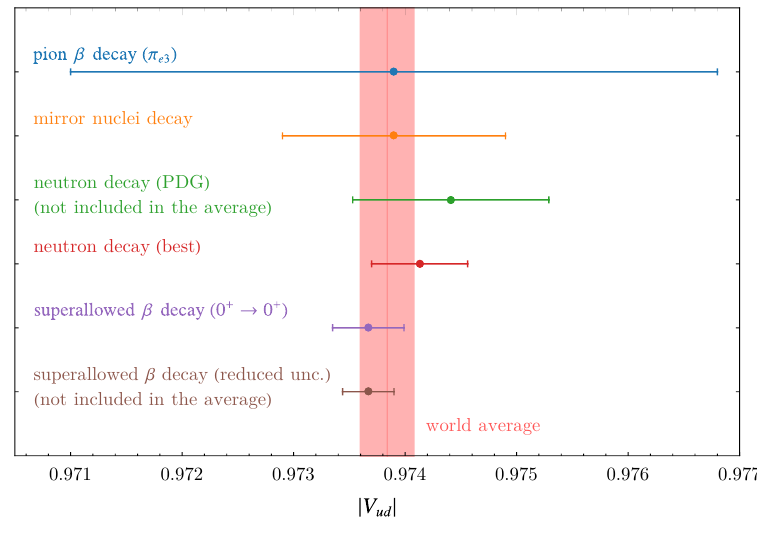
Figure 1 . Summary of the determinations of | V ud | from the various types of β decays. The red band represents our world average (2.1). The details of the extractions from neutron decay (best) and the super-allowed β decays (reduced uncertainty) are given in the main text. Note that the pion β decay, even though it is currently not competitive, is theoretically clean and will be strikingly improved by the PIONEER experiment [62].